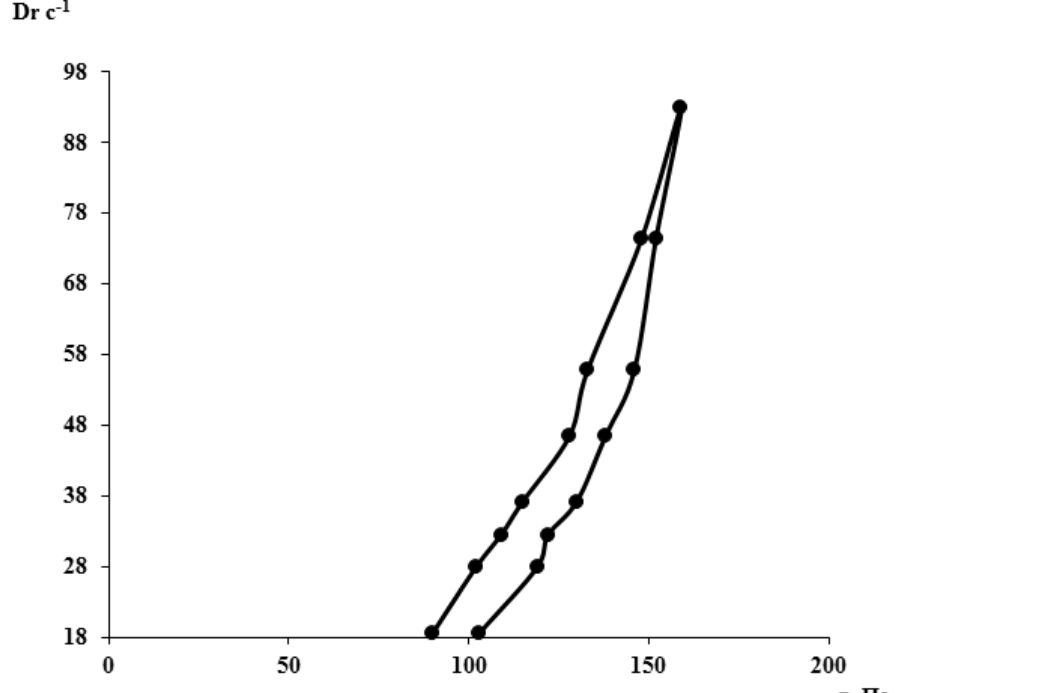
Fig. 4. Gel rheogram containing 1.1 % Carbopol® Ultrez 10, neutralized with sodium hydroxide to pH